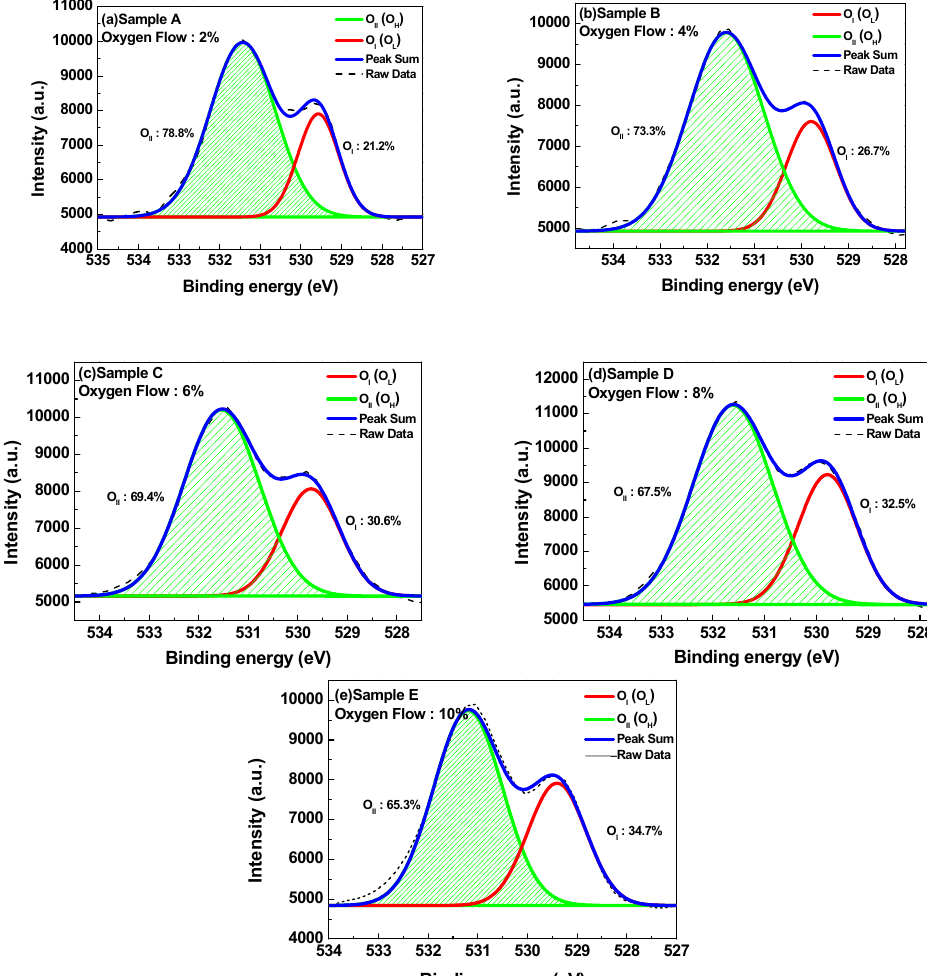
Figure 6. XPS O 1s spectra of InTiZnO thin films with various oxygen flow ratios: ( a ) Sample A, ( b ) Sample B, ( c ) Sample C, ( d ) Sample D, and ( e ) Sample E. Table 2. Electrical performance of ZnO-based TFTs reported in the literature